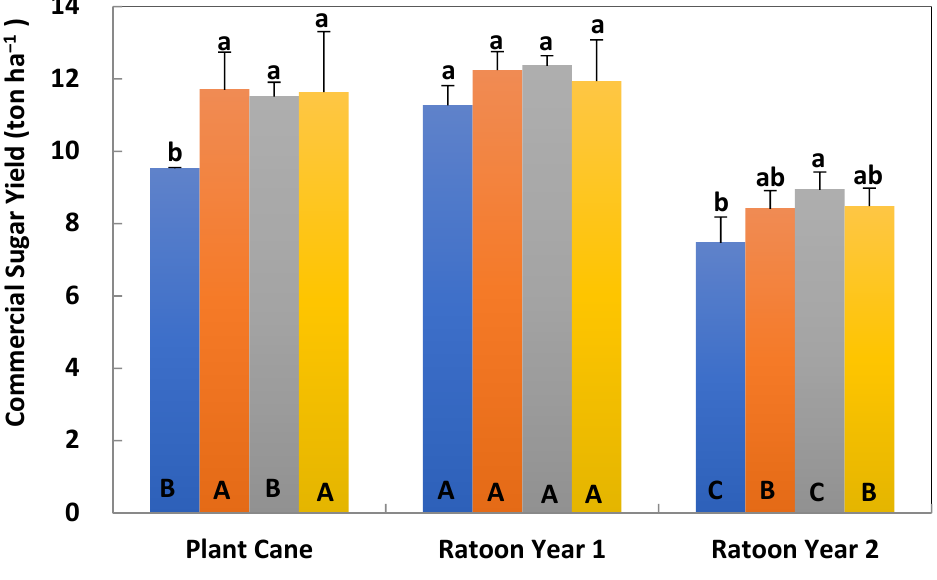
Figure 4. Commercial sugar yield for plant cane and two ratoons (mean and standard deviation). Different lower case letters within the same crop year are significantly different ( p < 0.05). The same treatment with different upper case letters for plant cane and two ratoons are significantly different ( p < 0.05).